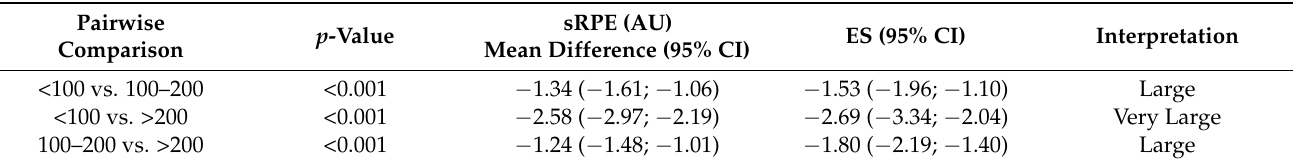
Table 1. Summary of post-hoc analysis results.